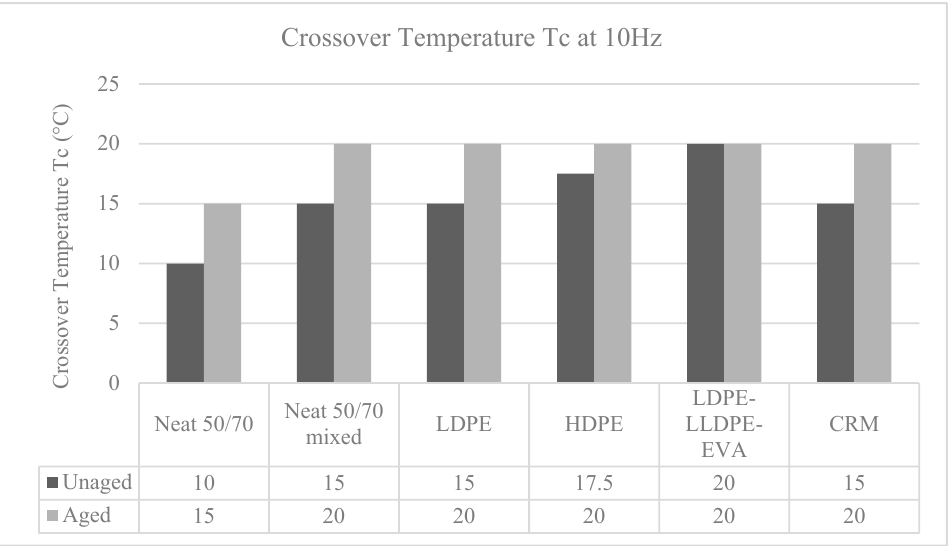
Figure 11. Crossover temperature, Tc, at 10 Hz, for all the binders studied.